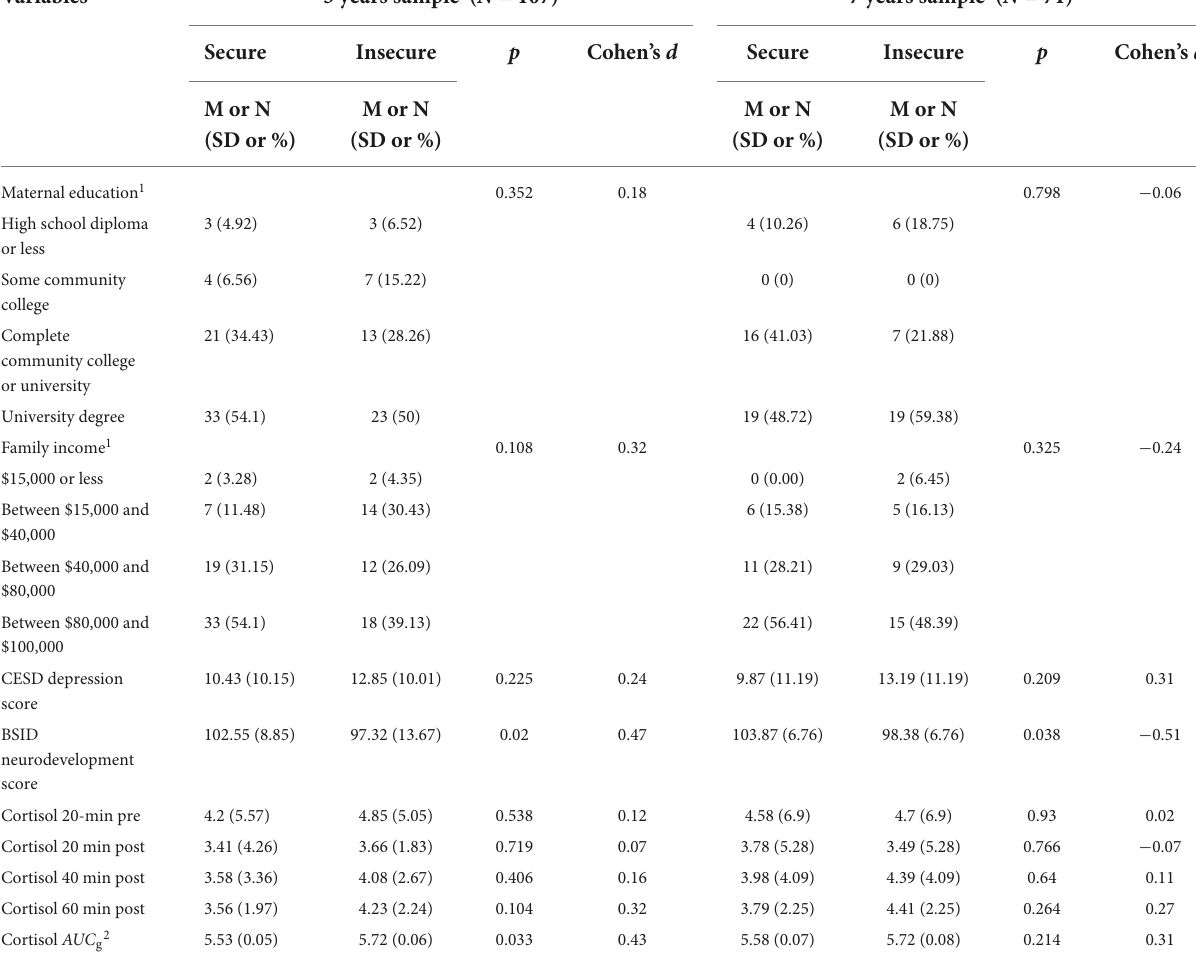
TABLE 1 Sample demographics and study variables descriptive